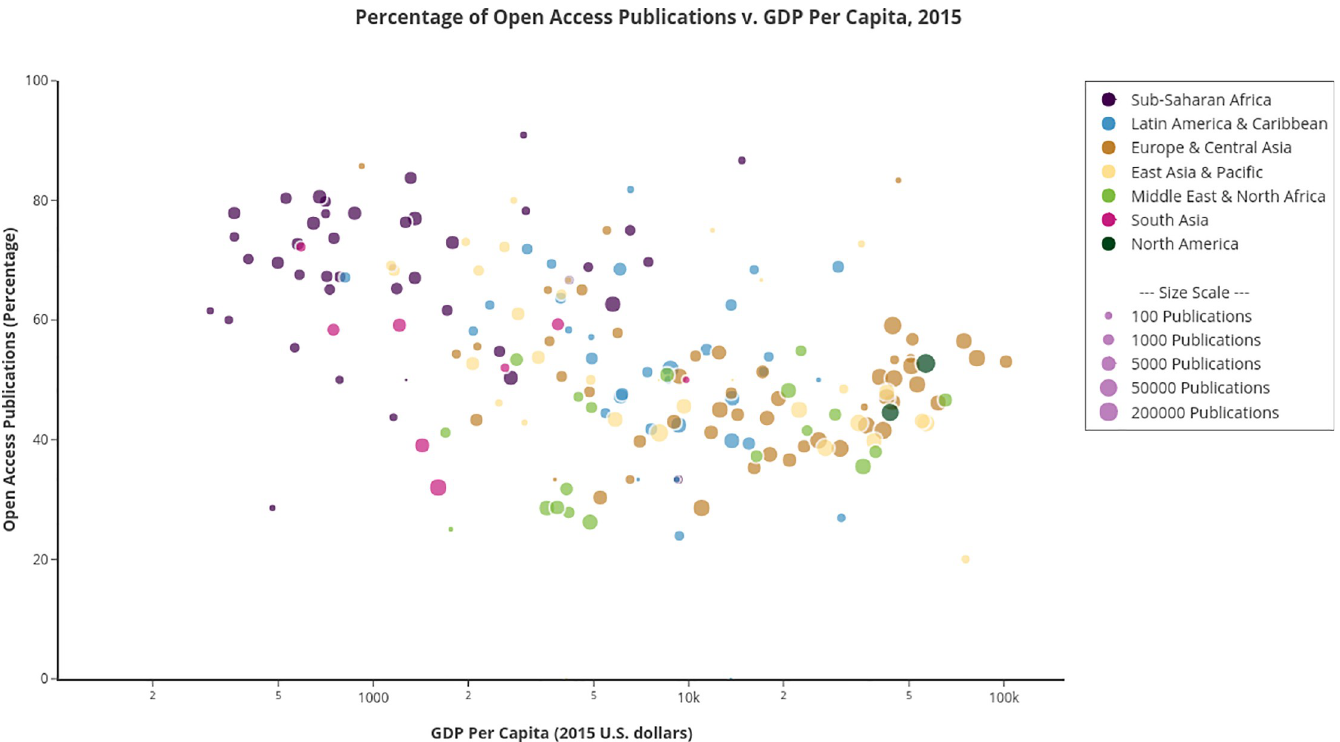
Fig 1. Geographic distribution of OA publications in biomedical research. Unique countries of affiliation (country-affiliations) were tabulated for each paper. For each country, the percentage of OA publication out of all papers with an affiliation in the country is reported. Per-capita income is from the World Bank. The size of each point is proportional to the log 2 -transformed number of publications.